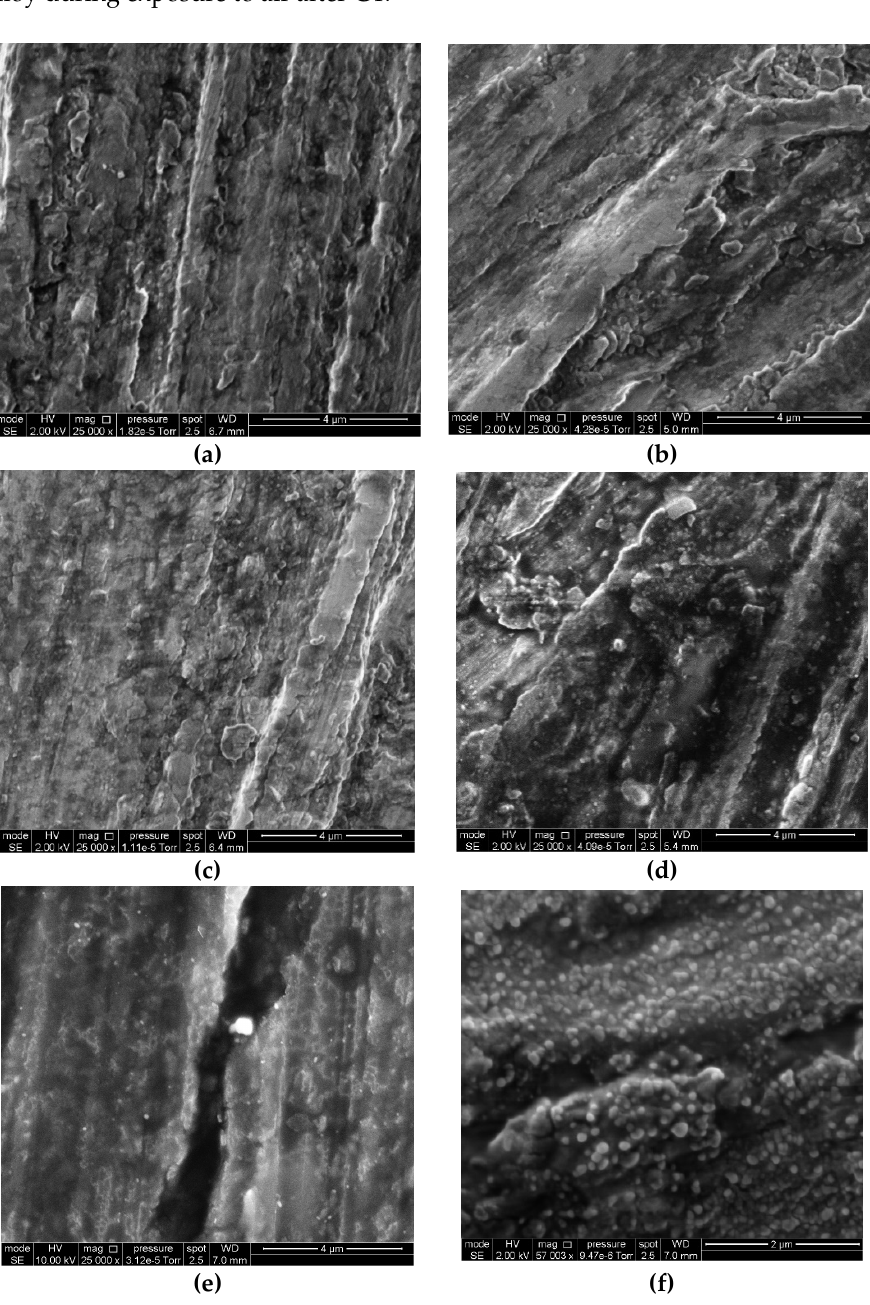
Figure 10. Micrographs of magnesium alloy samples. a —original state, b —original state, τ exp = 720 h; с -after TT, τ exp = 24 h; d —after TT, τ exp = 720 h; e —after CT, τ exp = 24 h; f —after CT, τ exp = 720 h.